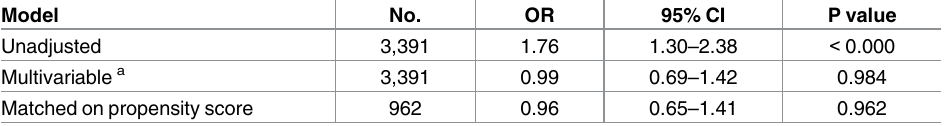
Table 4. Relationship between indeterminate QFT-GIT results and diabetes mellitus using multivari- able logistic regression and propensity score matched analysis. Model No. OR Unadjusted Multivariable a Matched on propensity score 962 0.962 QFT-GIT, QuantiFERON-TB Gold In-Tube test; OR, odds ratio; CI, confidence interval. a Selected variables included age, sex, chronic renal failure with renal replacement therapy, advanced liver cirrhosis, systemic steroids, diagnosis of tuberculosis, lymphocytopenia, anemia, and albumin and C- reactive protein